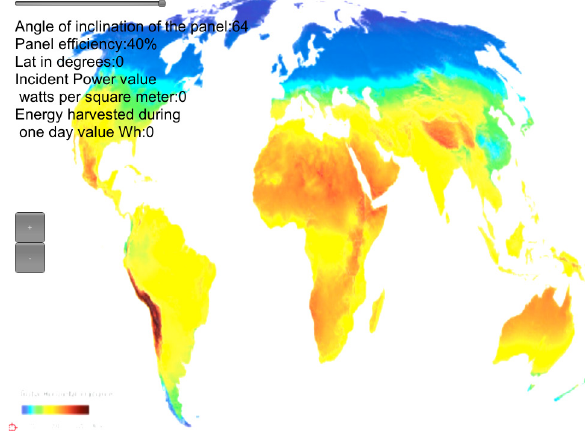
Figure 2. Main view of augmented virtuality application